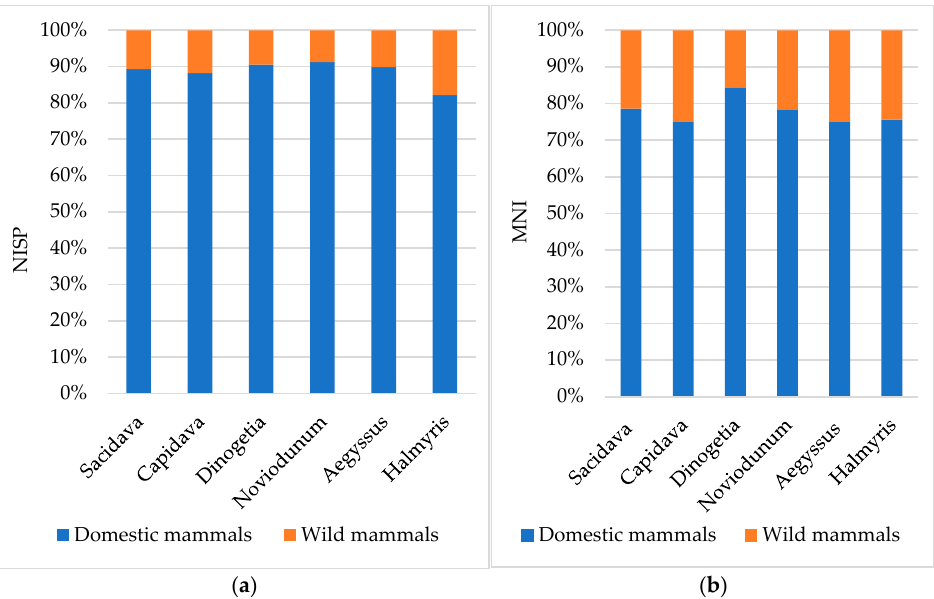
Figure 2. Proportions of wild and domestic species in the total identified mammal remains: ( a ) NISP—number of identified specimens; ( b ) MNI—minimal number of individuals.